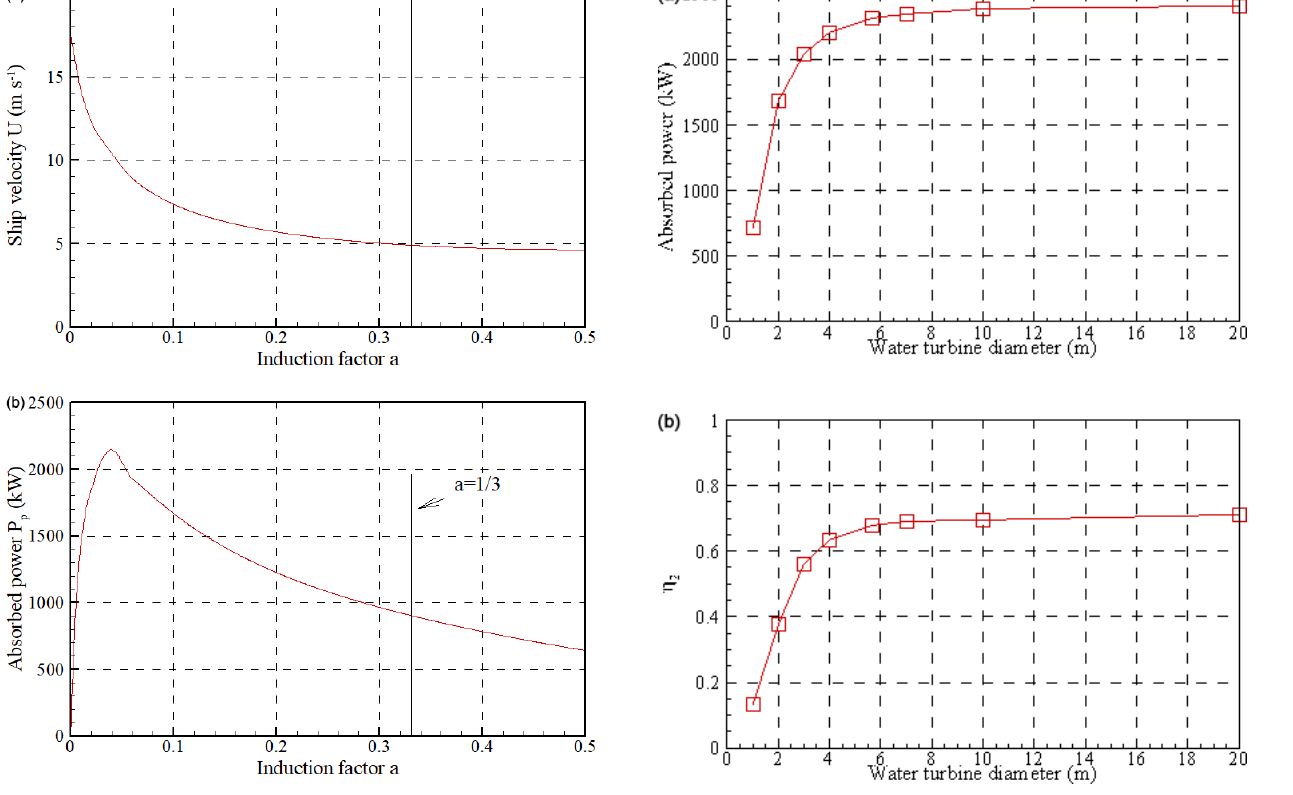
Figure 6. Absorbed power (a) and propulsion power to water tur- bine mechanical power (b) as function of the water turbine diame- ter. The true wind speed is 10ms − 1 and the true wind angle is 90 ◦ . The wind propulsion subsystems are Flettner rotors. The spin ratio is 3. Practical constraints on maximum rotational velocity, maximal thrust and cut-out speed are not taken into account in this